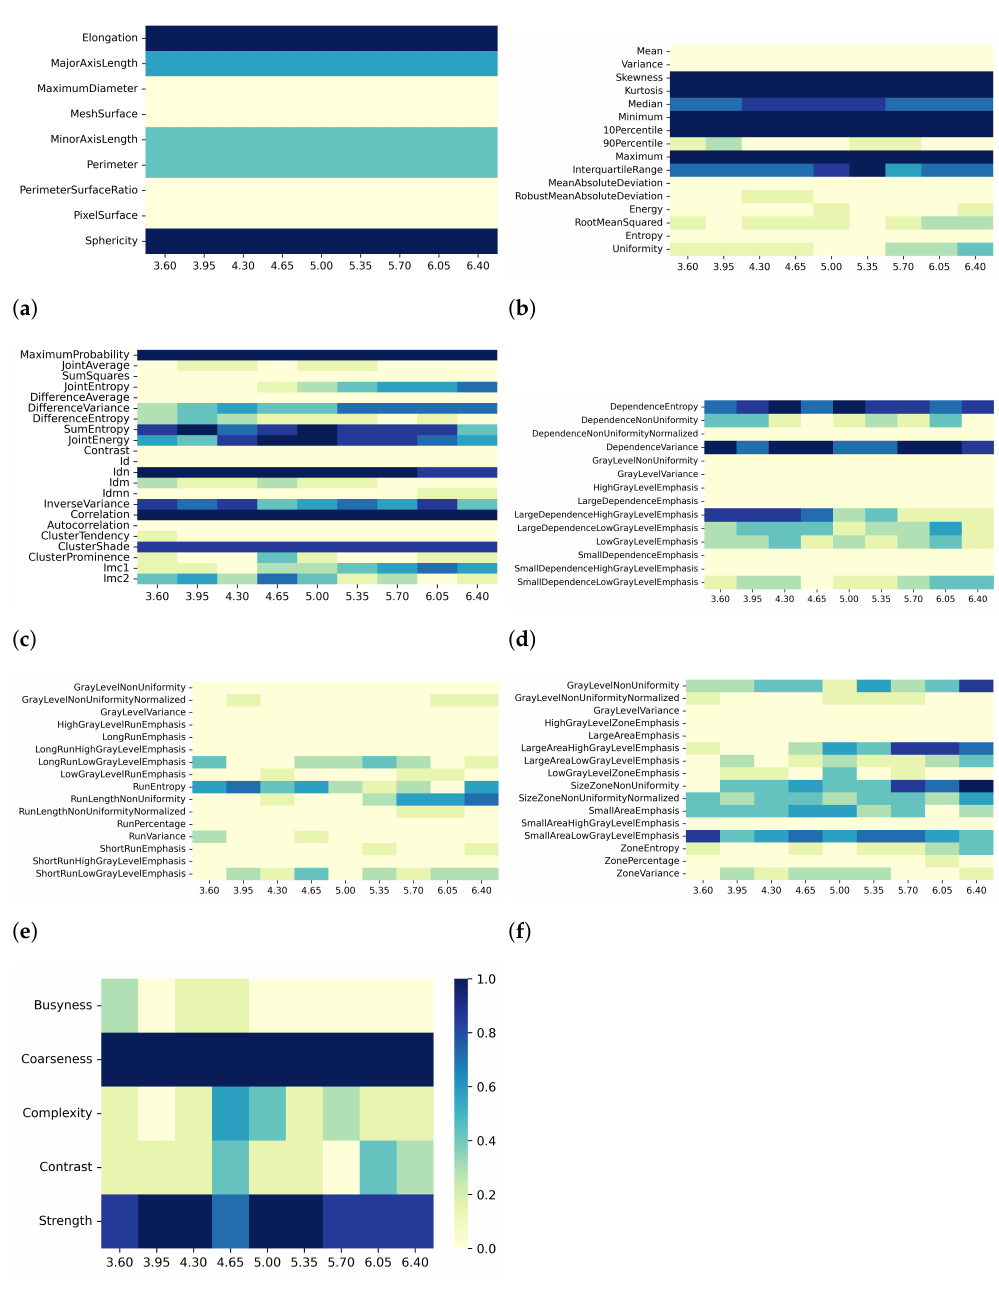
Figure 3. Heatmaps of remaining features from T1 maps after SCC-based dimensionality reduction for effect A (varying resampling voxel size, with fixed discretization bin width (ms)). The radiomic features are separated in classes: ( a ) 2D shape, ( b ) first order, ( c ) GLCM, ( d ) GLDM, ( e ) GLRLM, ( f ) GLSZM, ( g )